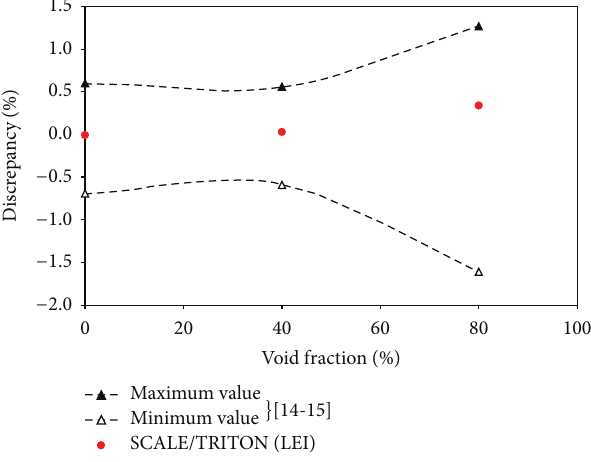
Figure 3: Comparison of the SCALE code and NEA BWR-MOX benchmark